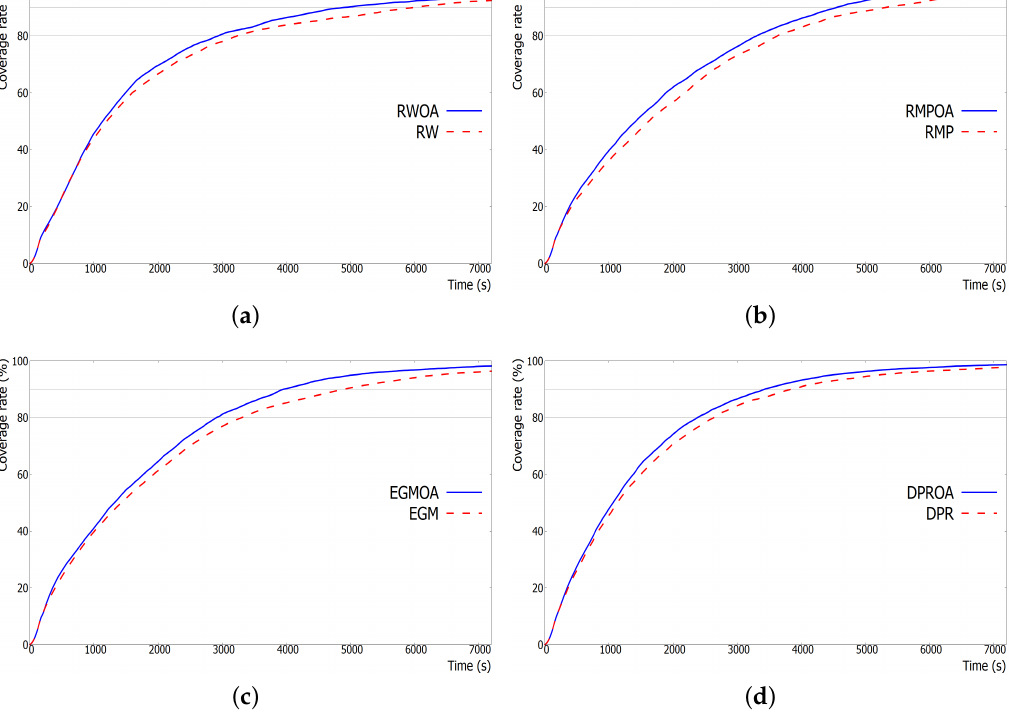
Figure 7. Coverage rate results with/without Overlap Avoidance: ( a ) Random Waypoint; ( b ) Random Markov Process; ( c ) Enhanced Gauss–Markov; and ( d ) Distributed Pheromone